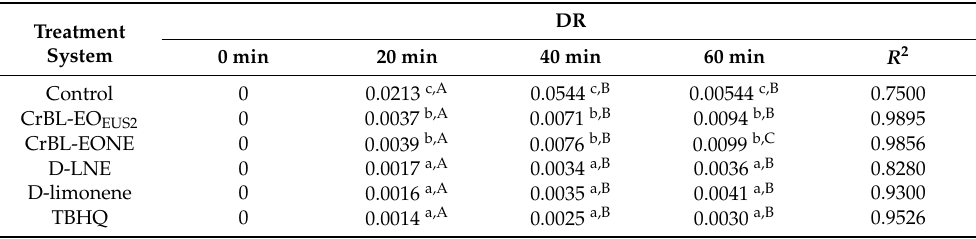
Table 4. The degradation rate (DR) and the R 2 values of the β -CLE coupled system in the presence of pre-enzymolysis and ultrasound–microwave treatment (CrBL-EO EUS2 ), C. reticulata leaf essential oil nanoemulsion (CrBL-EONE), D-limonene nanoemulsion (D-LNE), D-limonene, TBHQ, and control treatments between 0 min and the final incubation time (60 min) at 50 ◦ C. DR Treatment System 0 min 20 min 40 min 60 min Control